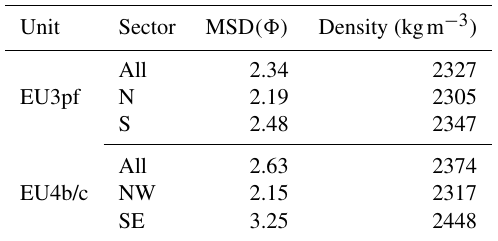
Table 3. MSD values and related densities for the different units